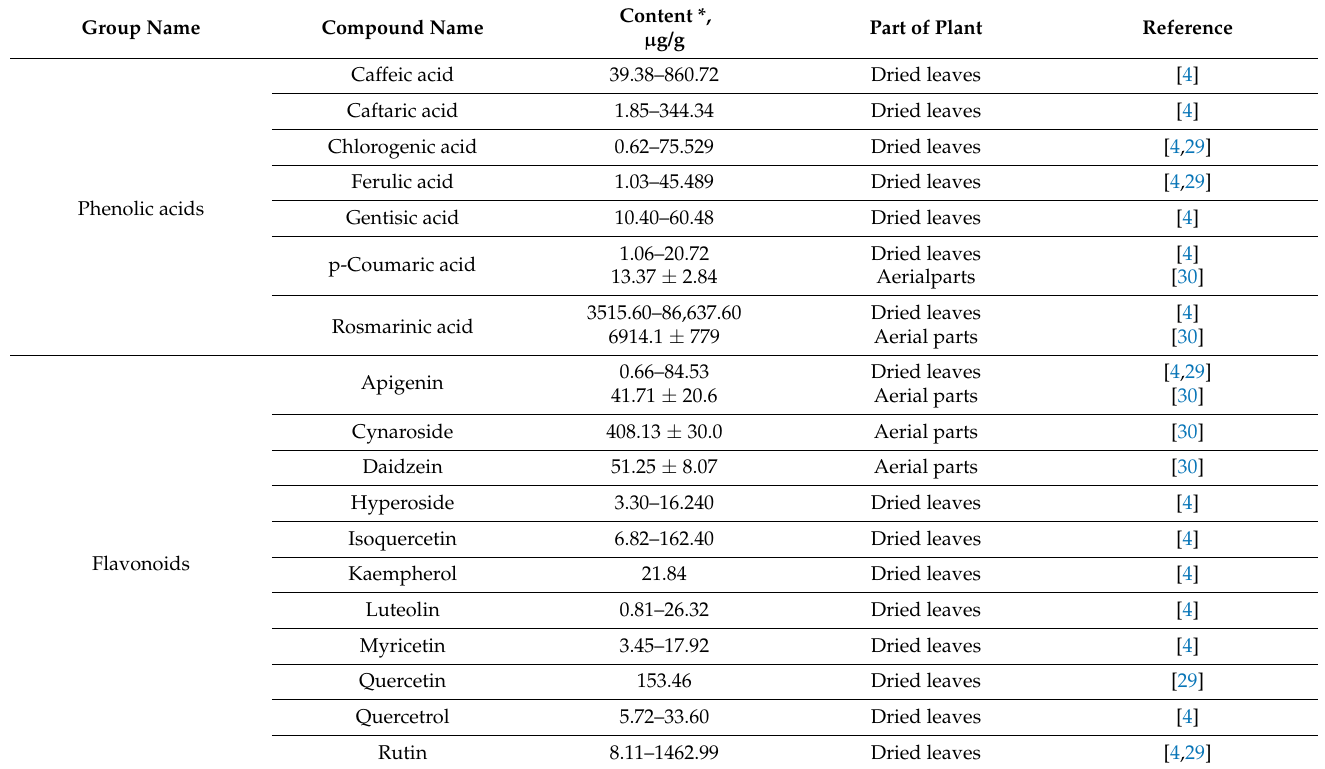
Table 3. Major polyphenolic compounds from Melissa officinalis